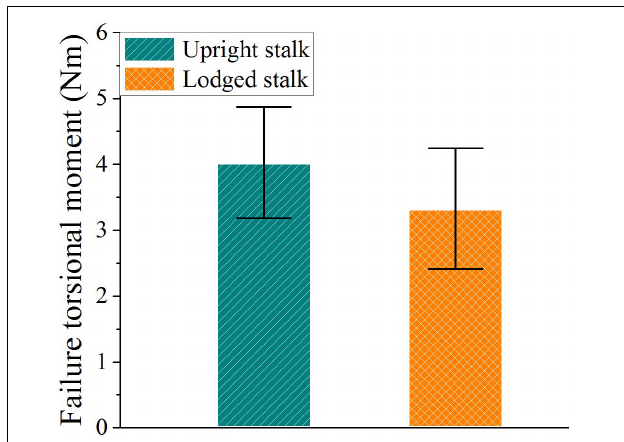
FIGURE 8 | Failure torsional moment of upright and lodged corn stalks. Error bars indicate standard deviations.